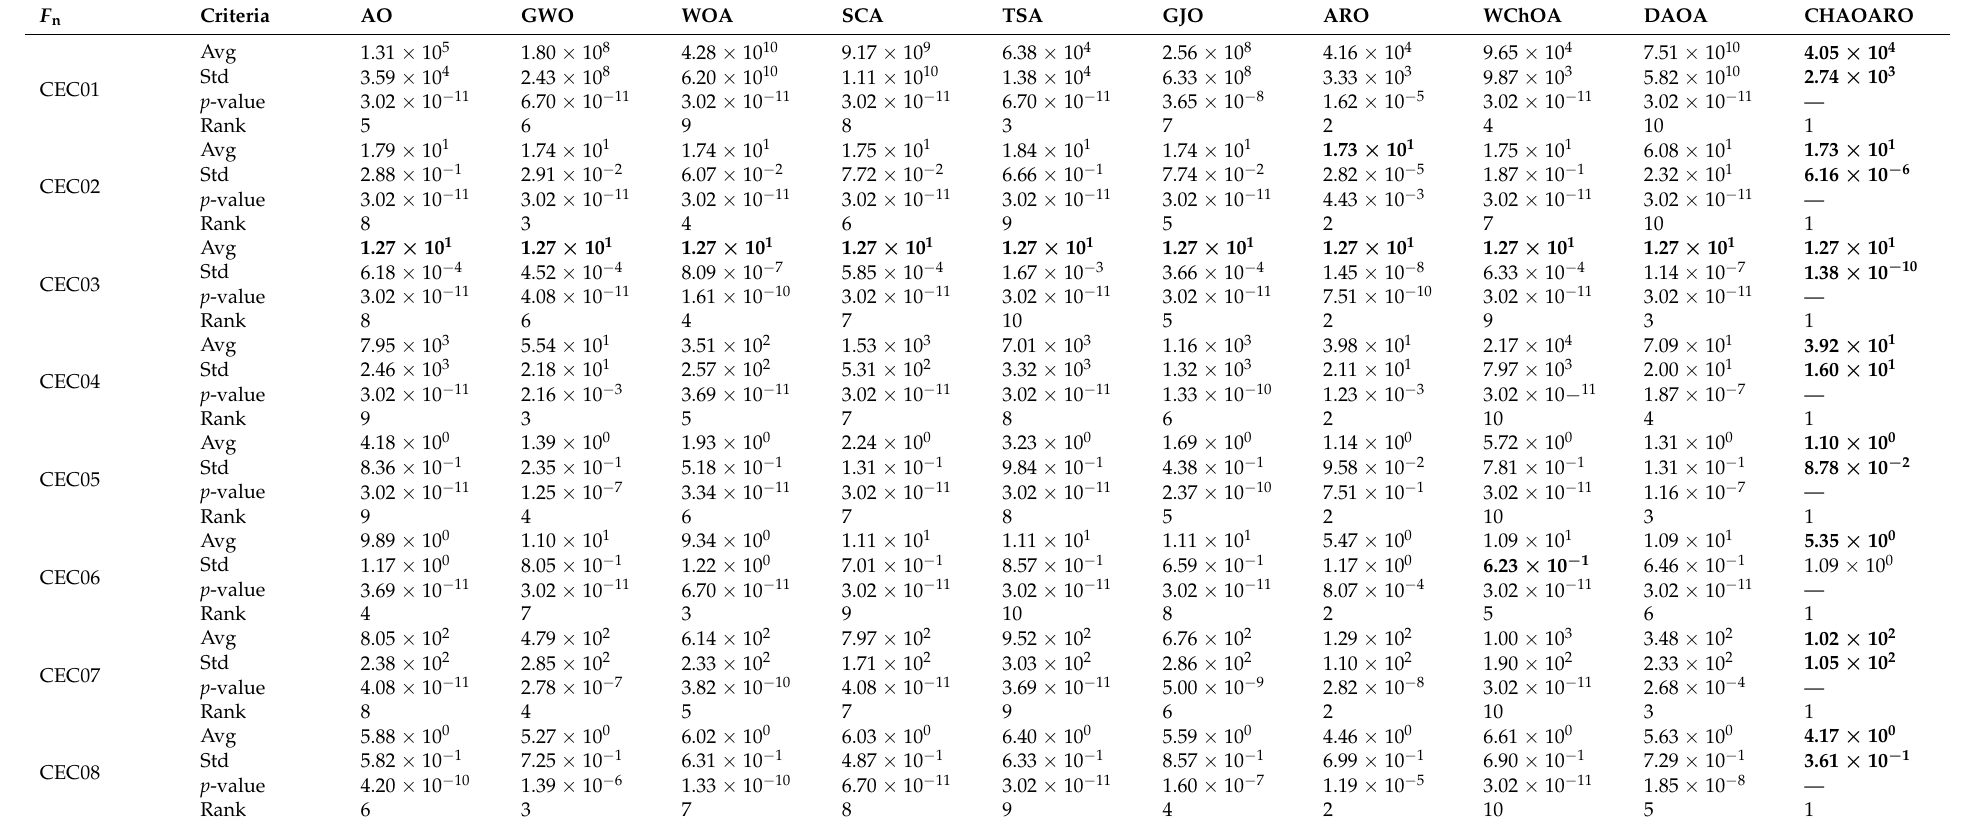
Table 11. Comparison results of CHAOARO and other algorithms on 10 CEC2019 test